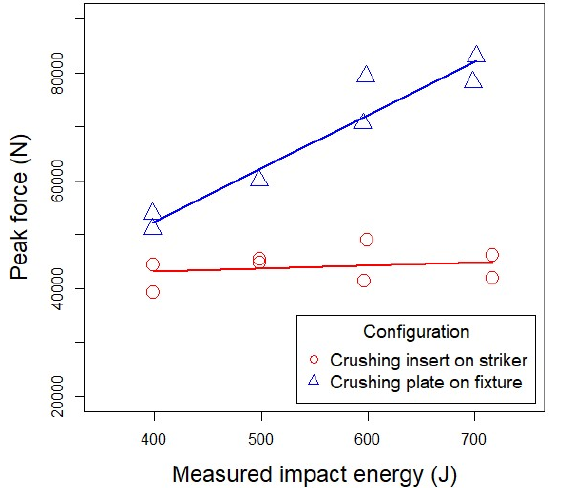
Figure 9: Specific Energy Absorption of the material as a function of the impact energy at constant falling mass of 60.2 kg.